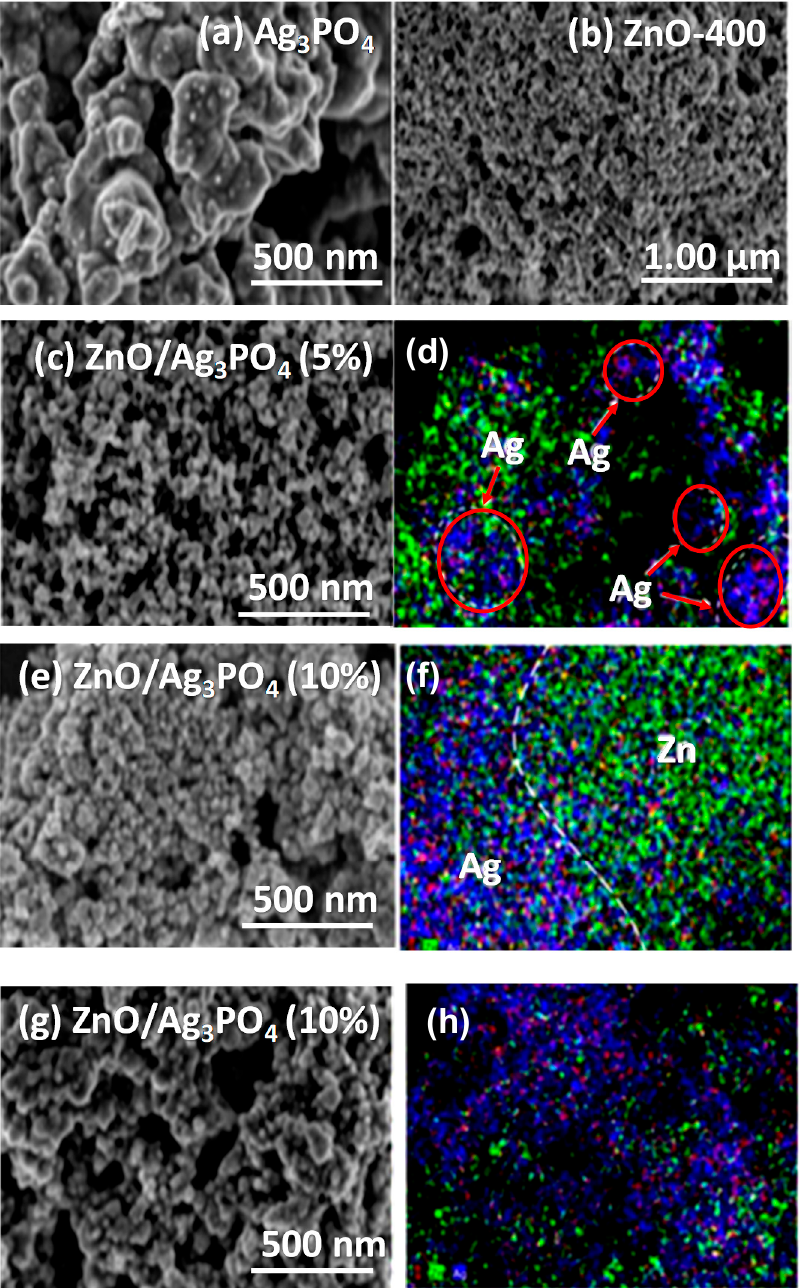
Figure 3. SEM images of ZnO/Ag 3 PO 4 composites. ( a ) Ag 3 PO 4 ; ( b ) ZnO-400; ( c ) and ( d ) ZnO/Ag 3 PO 4 (5%); ( e ) and ( f ) ZnO/Ag 3 PO 4 (10%); and ( g ) and ( h ) ZnO/Ag 3 PO 4 (10%).